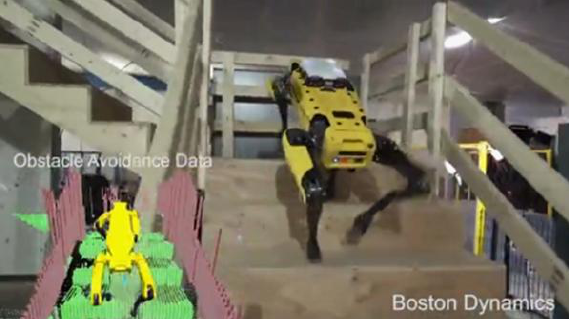
Figure 3: Boston Dynamics robot climbing stairs, while avoiding obstacles: Source: Dailymail,